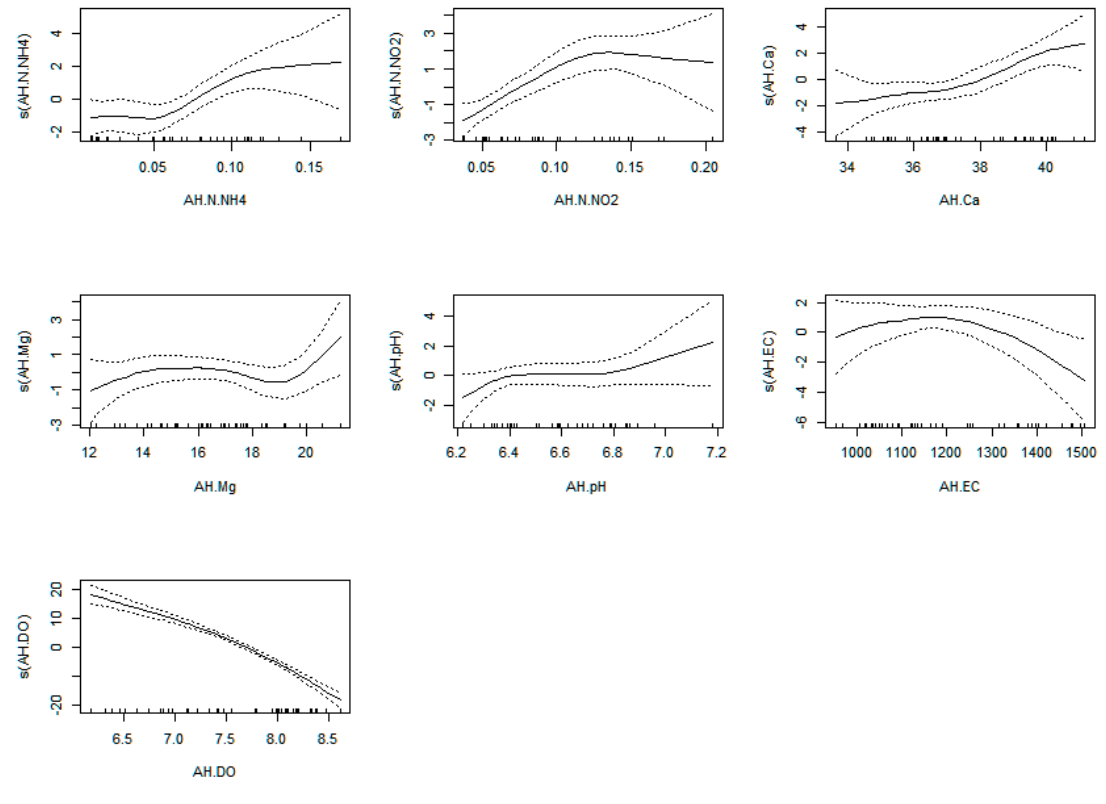
Figure A18. The GAM predictors influence over N-NO 3 for AH experimental variant.